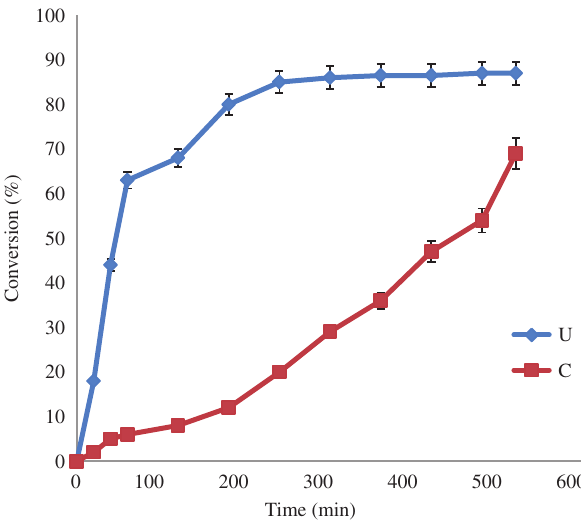
Figure 8: Comparison between Sonication & Conventional method (Sonication Condition- hexanol:triacetin ratio 1:1, hexane-3 ml, enzyme loading 4% (w/v), temperature 50 ° C, agitation speed 100 rpm, duty cycle 70% and frequency 25 kHz) (conventional method condition- hexanol:triacetin ratio 1:1, hexane-3 ml, enzyme loading 4% (w/v), temperature 50 ° C, agitation speed, 400